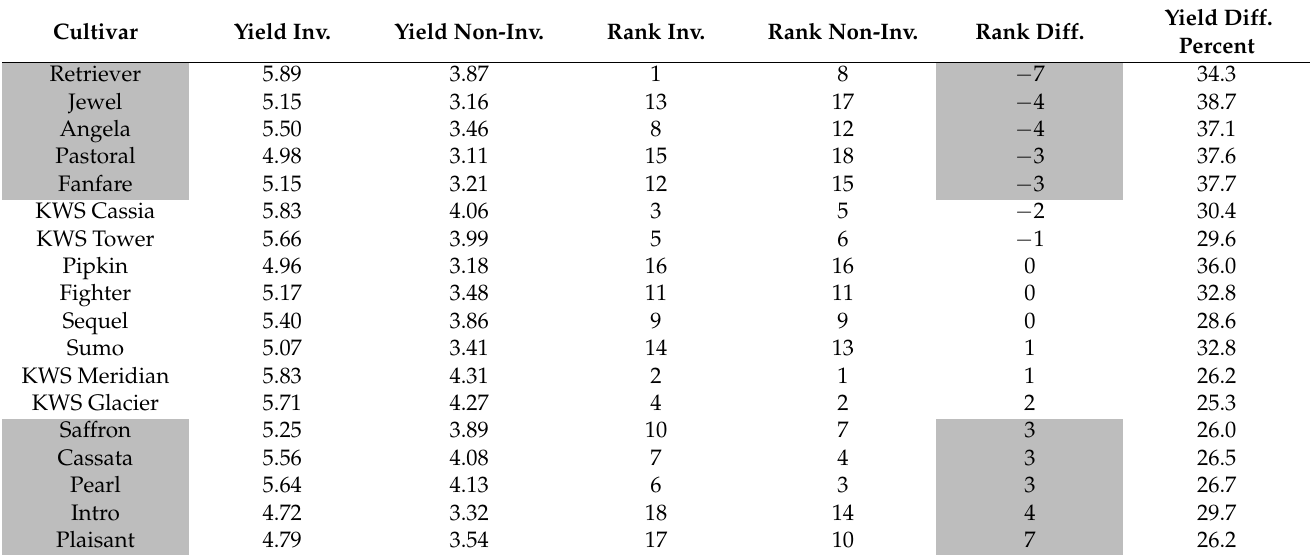
Table 4. Ranking of 18 winter barley cultivars grown from 2011 to 2014 by the difference between their inversion and non-inversion yield ranking. Yield Inv. Yield Non-Inv.